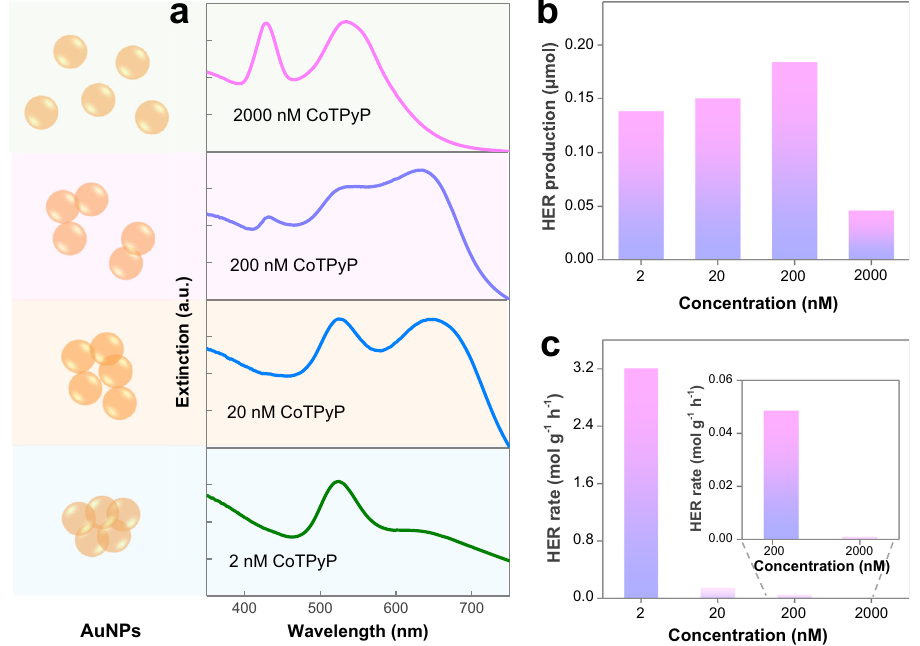
Fig. 3 | Effect of CoTPyP concentration to the improved HER. a Schematic illustration of AuNPs and UV − Vis extinction spectra of the AuNP@CoTPyP suspensions at different concentrations of CoTPyP. b-c HER production and HER rates at different concentrations of